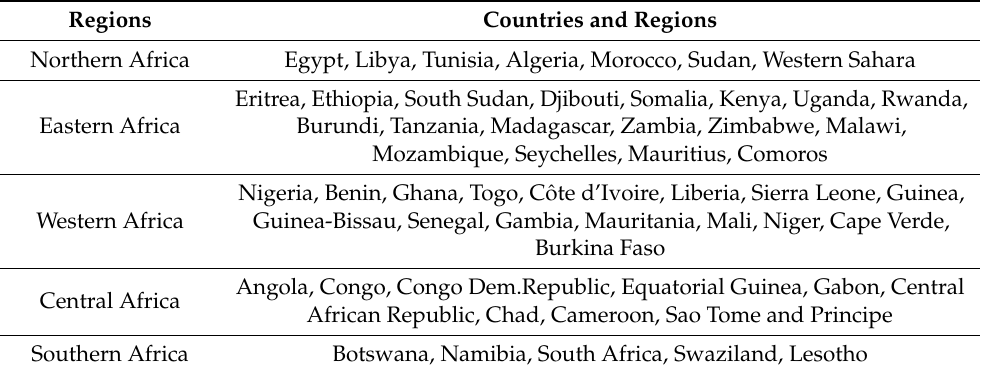
Table 3. The list of countries and regions in Africa. Regions Countries and